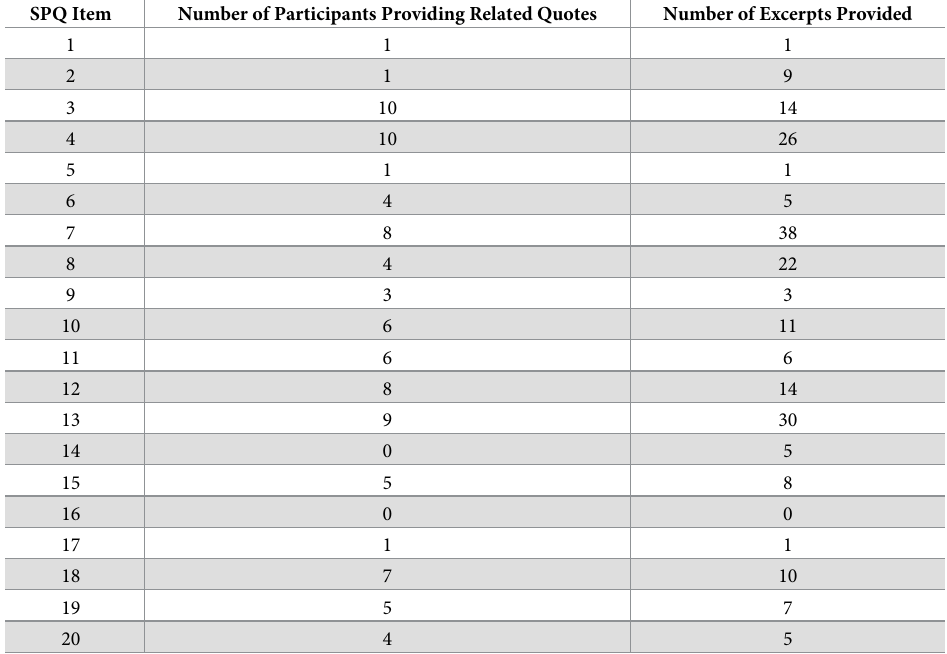
Table 2. Number of participants and coded qualitative excerpts provided for each SPQ item.